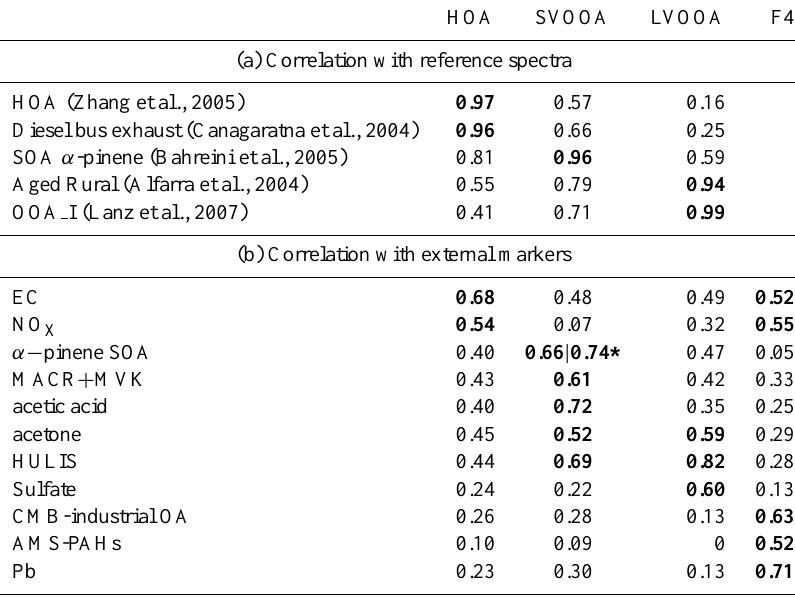
Table 1. Pearson correlation coefficients, R ( P ≤ 0.05 ): (a) between factor’s mass spectra and reference mass spectra drawn from previous ambient, emission and chamber studies and (b) between factors time series and external markers time series. R coefficients greater than 0.5 are marked in bold